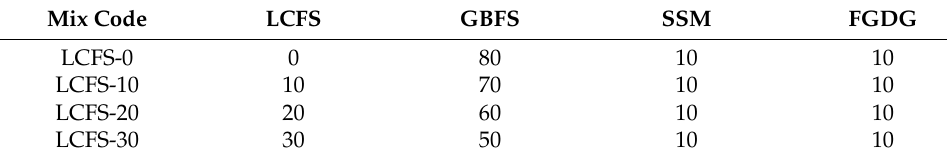
Table 2. The mix proportions of LCFS-GBFS cementitious